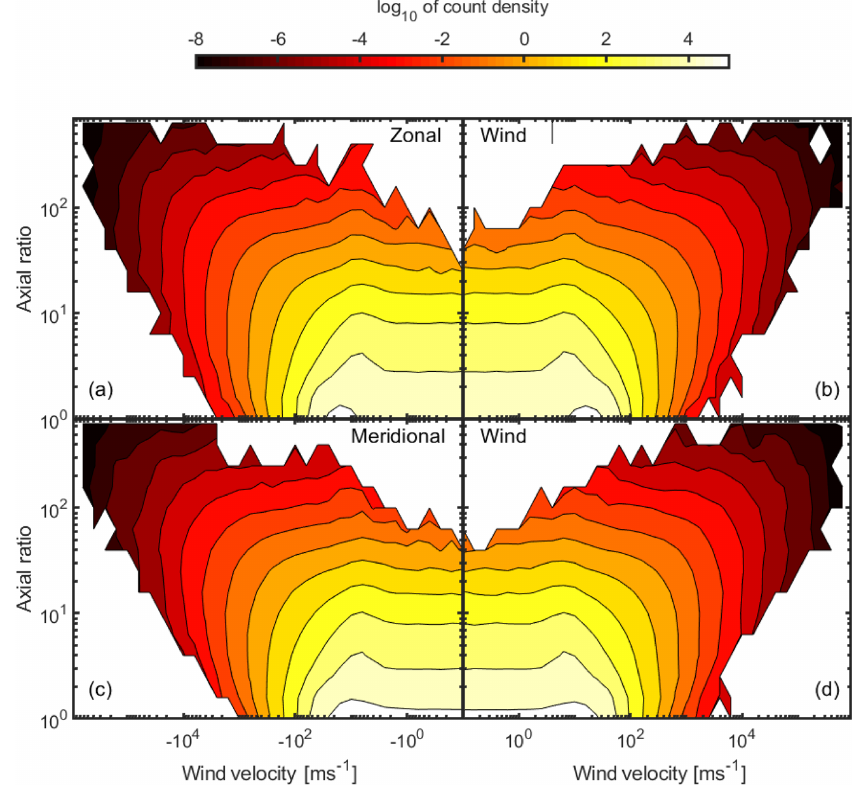
Figure 4. Wind speed vs. axial ratio for 28 million data points, taken from the Rothera MF radar from 2002 to 2016. The four panels represent the axial ratio binned by four directions: (a) west, (b) east, (c) south and (d) north. Note that the colour scale is the logarithm of the count density.